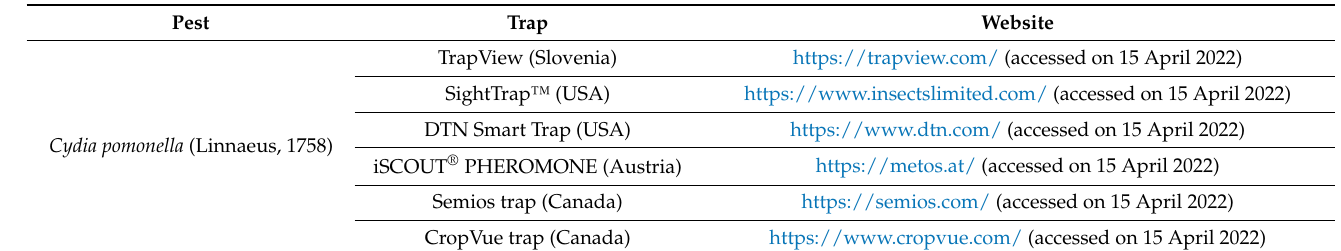
Table 1. Commercially available devices for automatic monitoring of codling moth ( C. pomonella ). Pest Trap Website